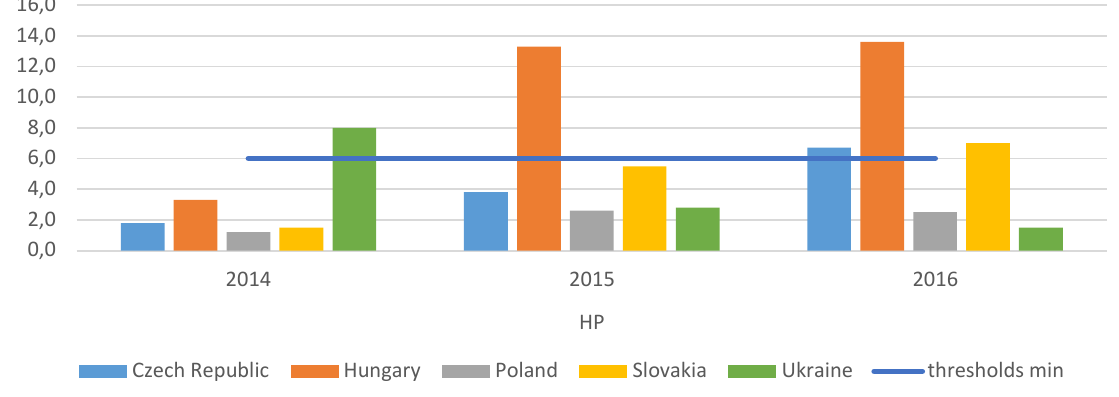
Figure 5. House price index in Ukraine and Visegrad Countries, 2014–2016